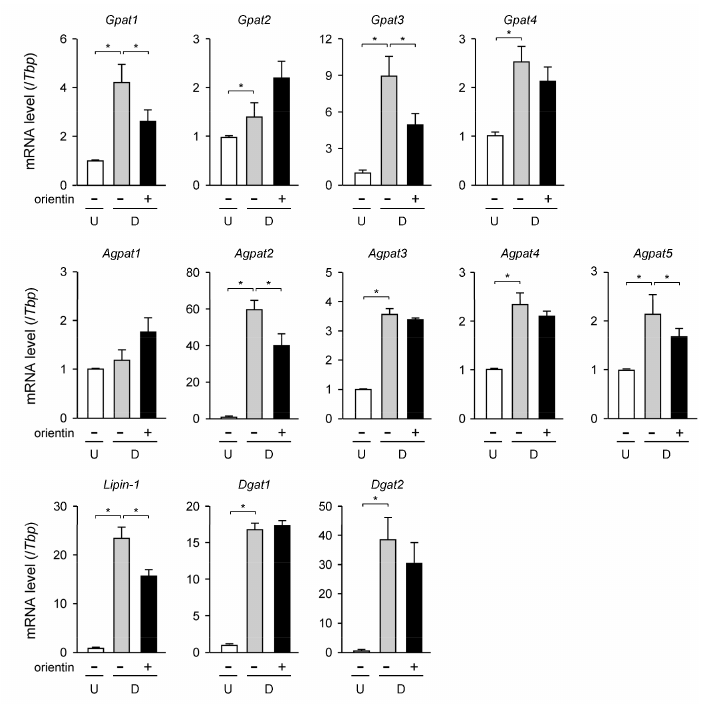
Figure 3. Effect on expression level of TG synthetic enzyme genes by orientin. 3T3-L1 cells were caused to differentiate into adipocytes as described in the legend of Figure 2A. Data are shown as the means ± S.D. from three experiments. * p < 0.01, as shown by the brackets.